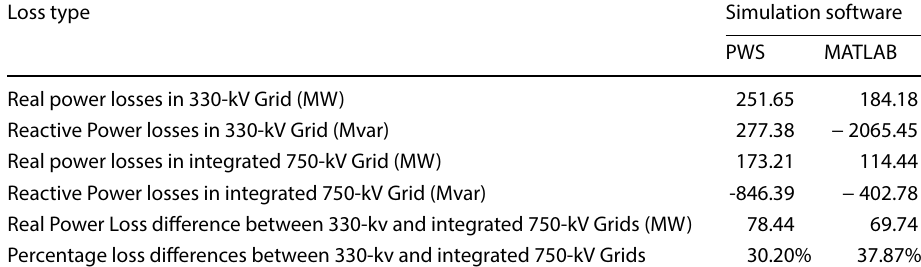
Table 4 Contingency results for 330-kV